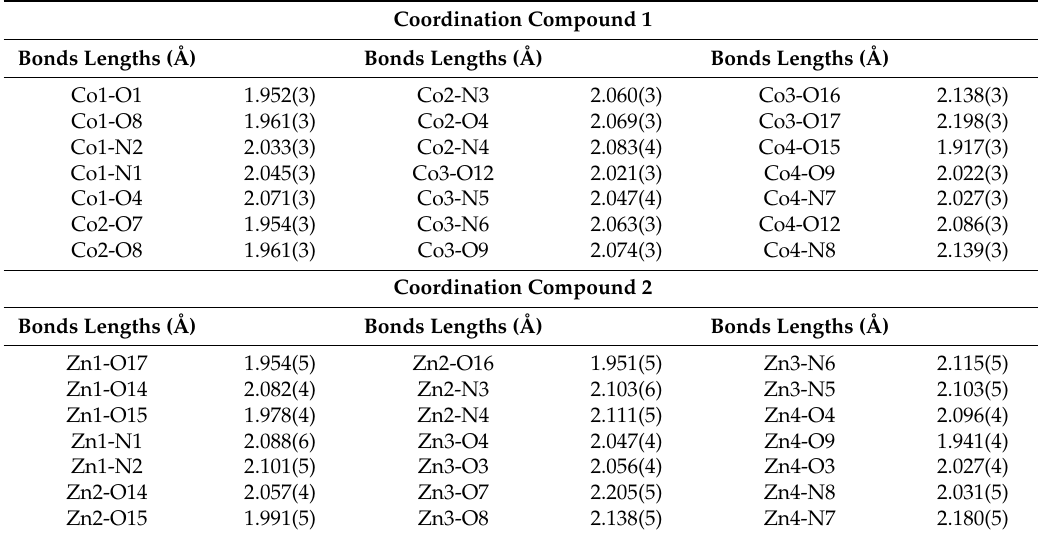
Table 1. Selected bond lengths (Å) for the coordination compounds 1 and 2